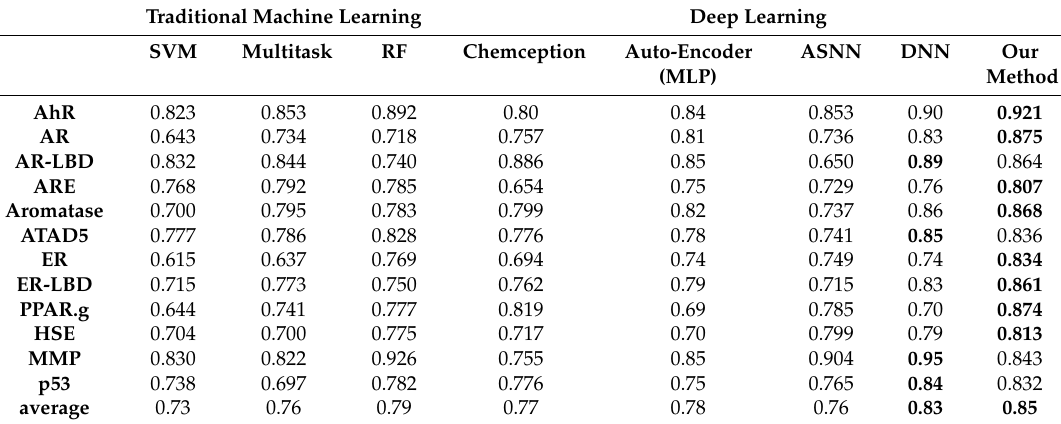
Table 5. AUC results of di ff erent methods. In the methods listed in the table, the best value of each property is marked in bold. The results of all other methods except ours are obtained through their